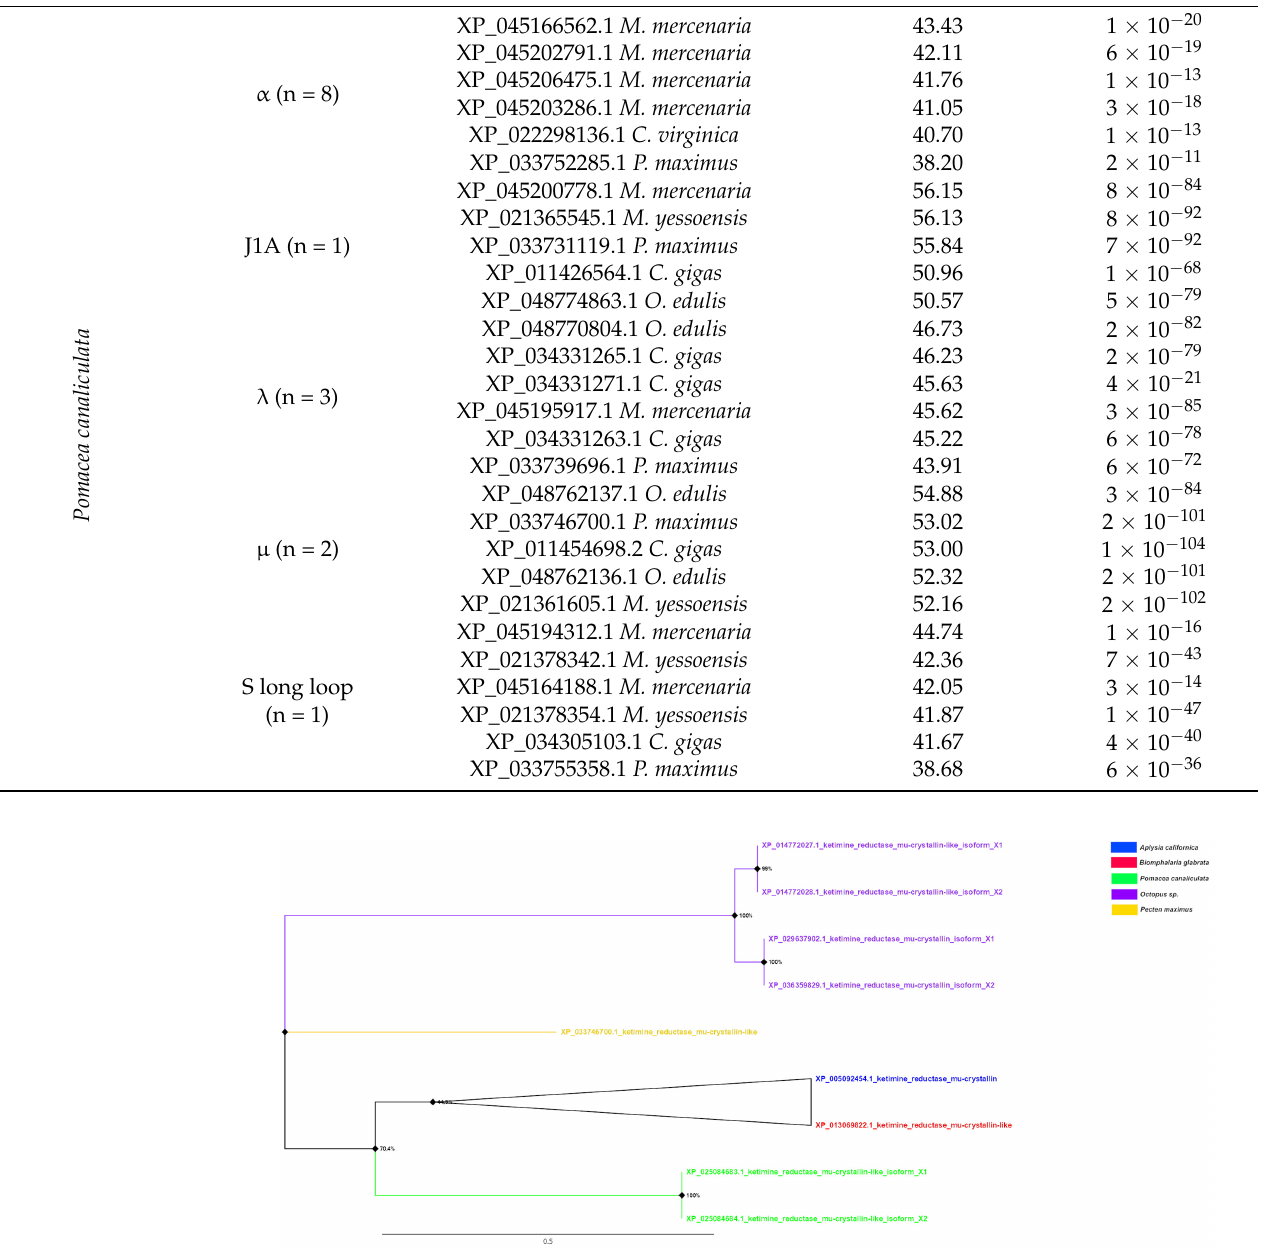
Figure 8. Phylogenetic tree of μ -crystallins of molluscs.